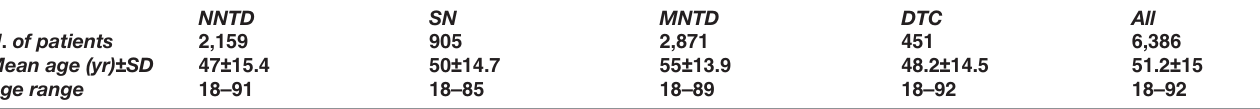
Table 2. Thyroid Diseases, Age and Extra-Thyroidal Malignancies in the 6,386 Female Patients Included in the